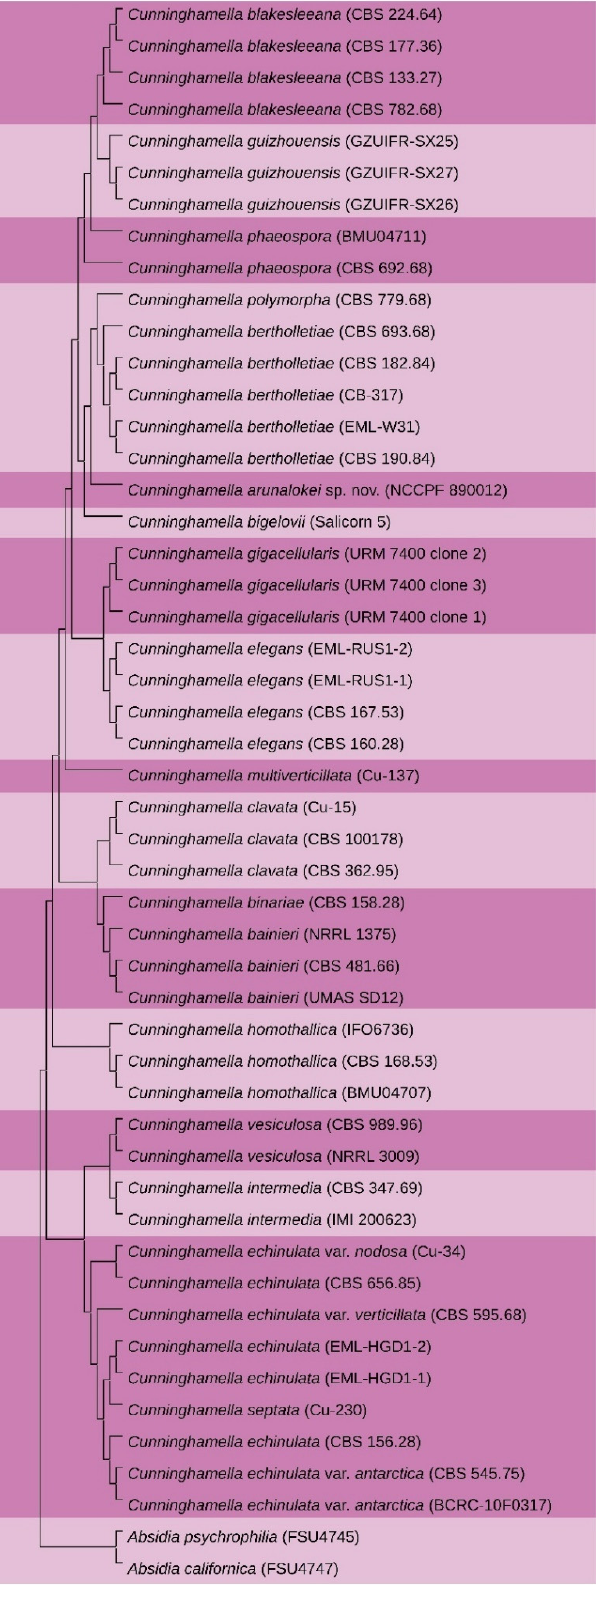
Figure 3. Super-tree constructed using three genes i.e., ITS, 28s, and EF-1 clustered isolate Cunning- hamella arunalokei (NCCPF 890012) closely with C. bigelovii.